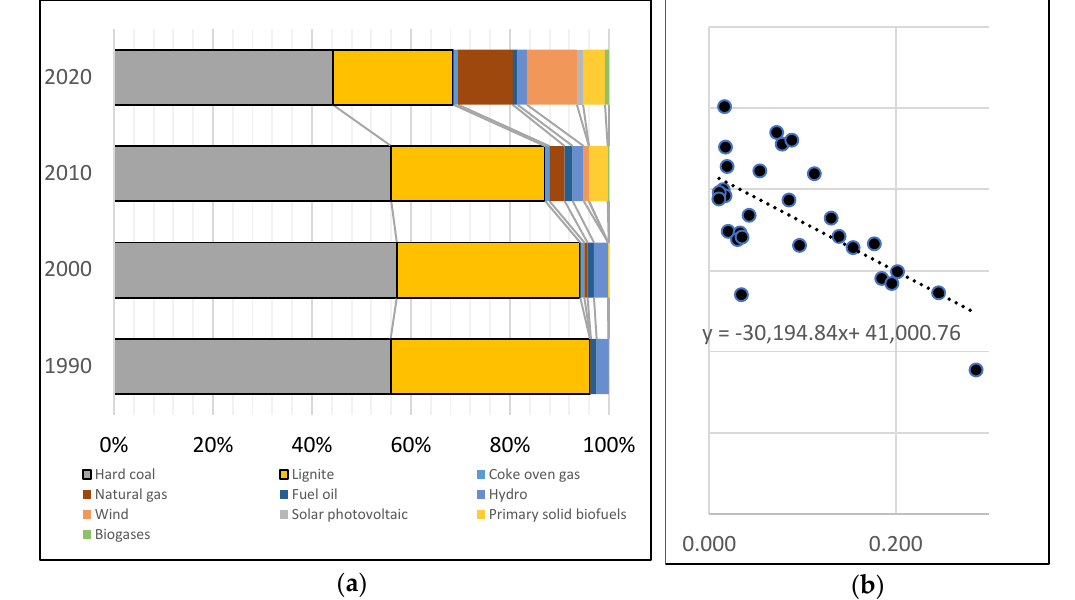
Figure 9. Electricity production sources in Poland in 1990 – 2020; ( a ) The structure of electricity generation in Poland in 1990, 2000, 2010 and 2020; ( b ) The regression curve of the intensity of changes in the structure of electricity generation and the coal production in Poland in 1990 – 2020 Source: own study based on Eurostat. Available online: https://ec.europa.eu/eurostat/data/database (accessed on 22 February 2022).